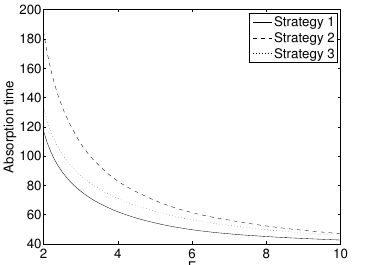
Figure 7: Computation of τ for differ- ent strategies